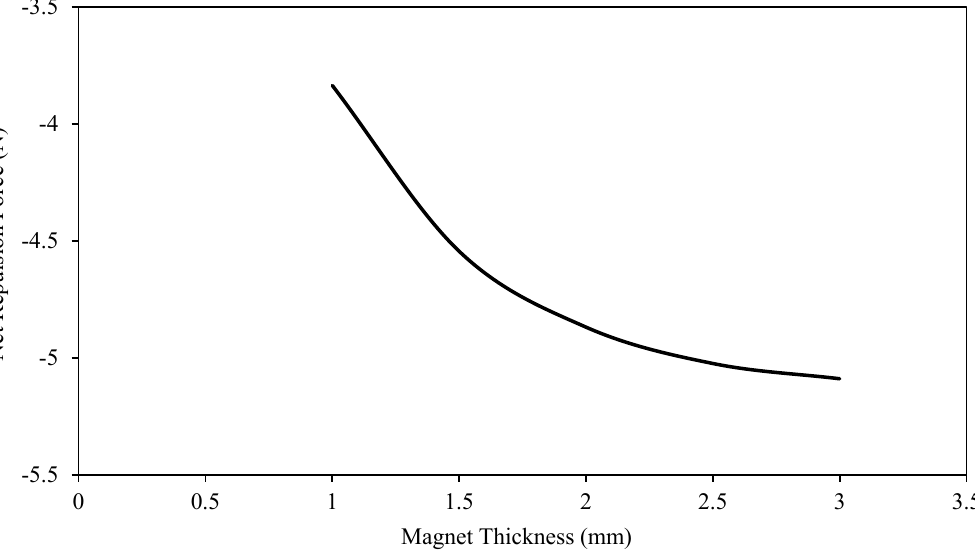
Figure 11. Net repulsion force estimated at the zero-stroke position versus magnet thickness.